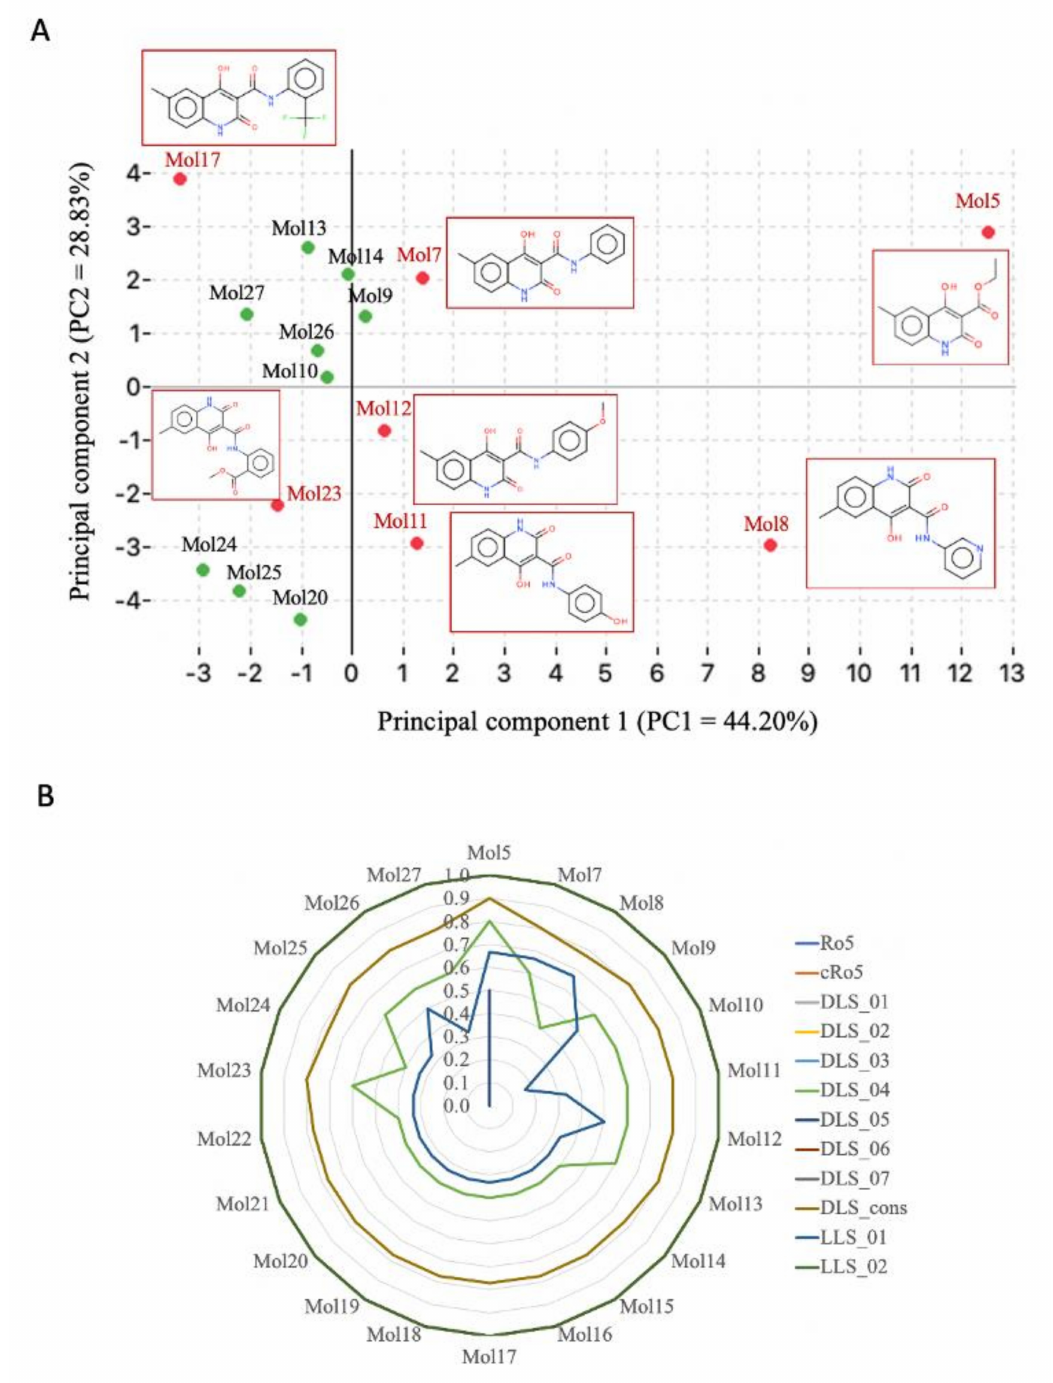
Figure 7. Molecular descriptor analysis. ( A ) A graphical 2D representation of the principal component analysis of molecular descriptors. PC1 explaining 44.20% of the variation in descriptor values is on the X-axis, and PC2 explaining 28.83% of the variation in descriptor values is on the y-axis. The descriptors used for the analysis belong to two major categories of molecular descriptors: (1) drug-like indices; and (2) molecular properties. Structures shown in red boxes, which correspond to the red dots on the figure, serve as structural examples. ( B ) Radar plot of drug-like molecular descriptors. Both drug-like scores (DLS) and lead-like scores (LLS) were calculated for molecules 5 and 7 – 22 . A molecule is drug-like or lead-like if its DLS or LLS is ≥